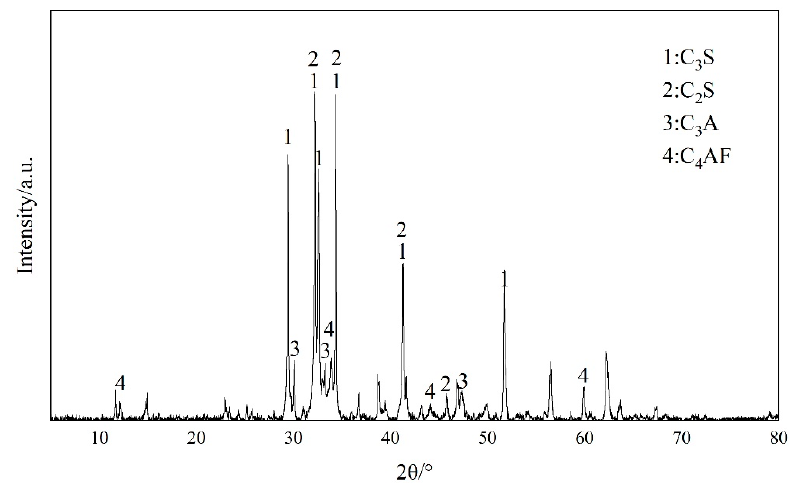
Figure 1. XRD pattern of P·II 52.5 Portland cement.